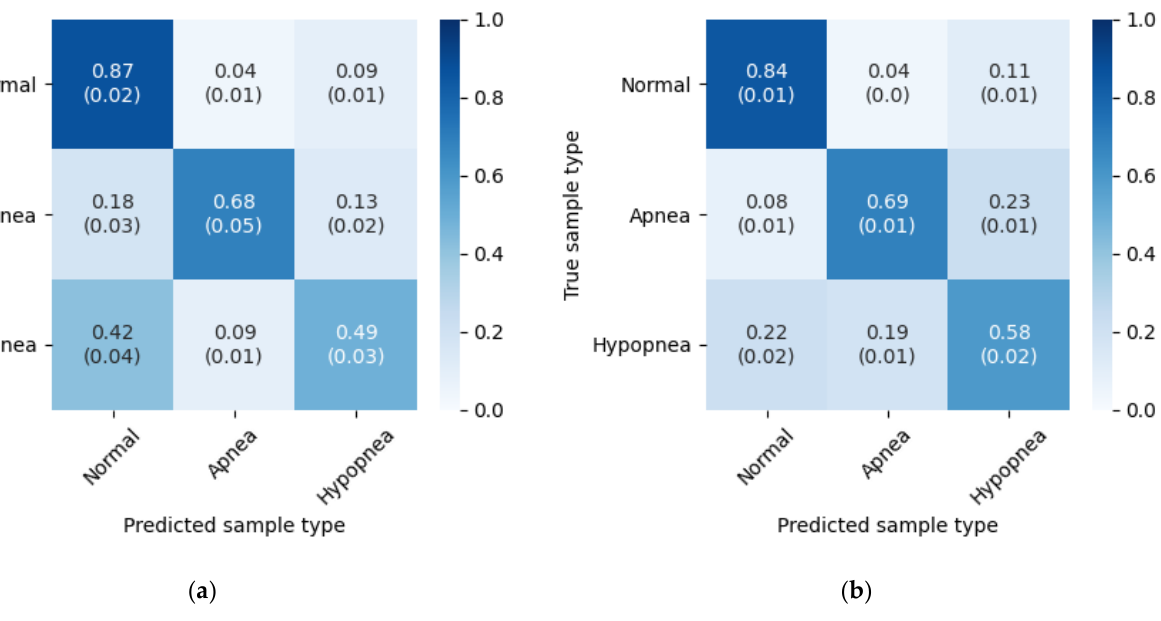
Figure 6. Three class inference confusion matrices, mean and standard deviation from 5 experiment iterations. Values are row-normalized and rounded to two decimal places. ( a ) Test set from SHHS-1 database; ( b ) PhysioNet Sleep Database.